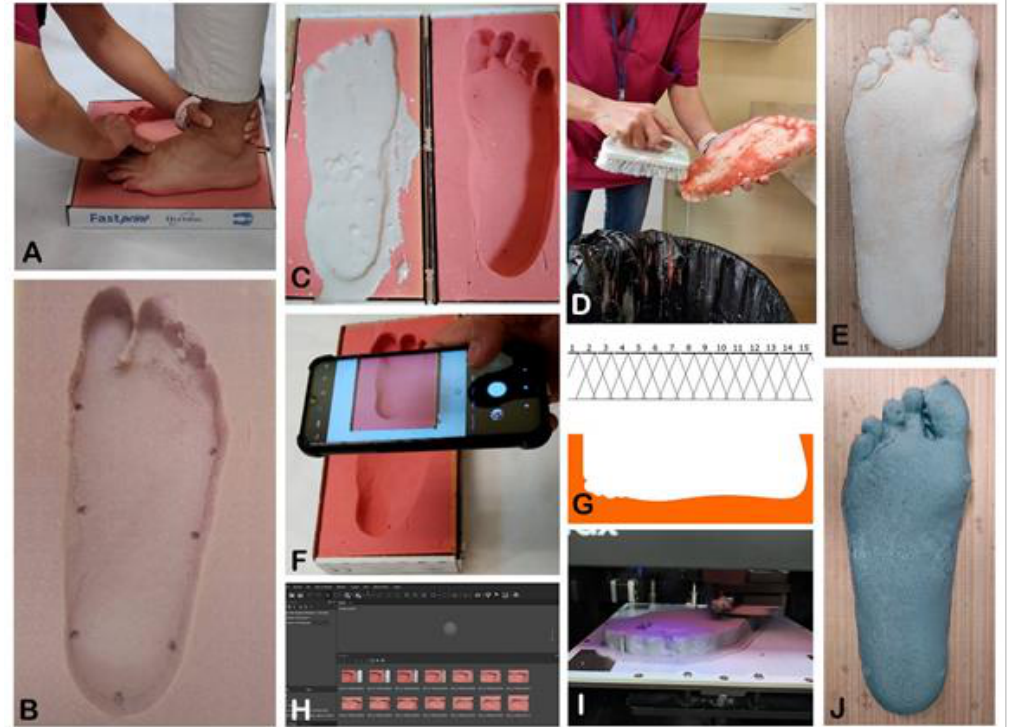
Figure 1. Procedure from taking the negative cast to creating the positive casts with both techniques. ( A ): Obtaining cast in phenolic foam (negative cast of the foot). ( B ): References on negative cast. ( C ): Plaster casting. ( D ): Cleaning the plaster cast. ( E ): Positive plaster cast obtained by traditional method. ( F ) and ( G ): Photogrammetry and overlapping photo method on the negative cast of the foot using a smartphone. ( H ): 3D modeling on a PC. ( I ): 3D printing of positive cast. ( J ): Positive cast obtained by digital manufacture.